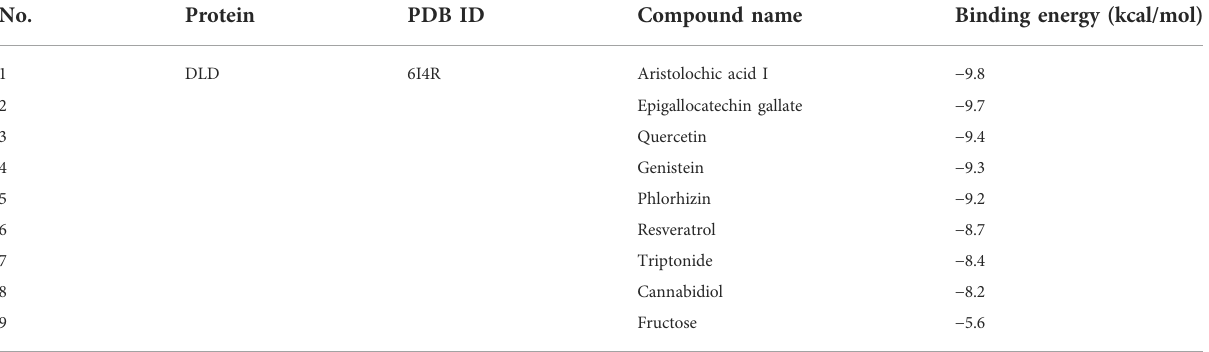
TABLE 1 The binding energy of nine TCM active components to DLD by molecular docking.